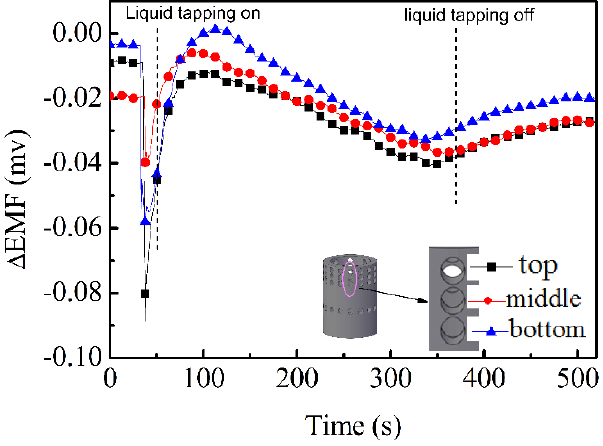
Figure 7. Effect of the height of sensor locations on EMF signals along south direction at inner wall.